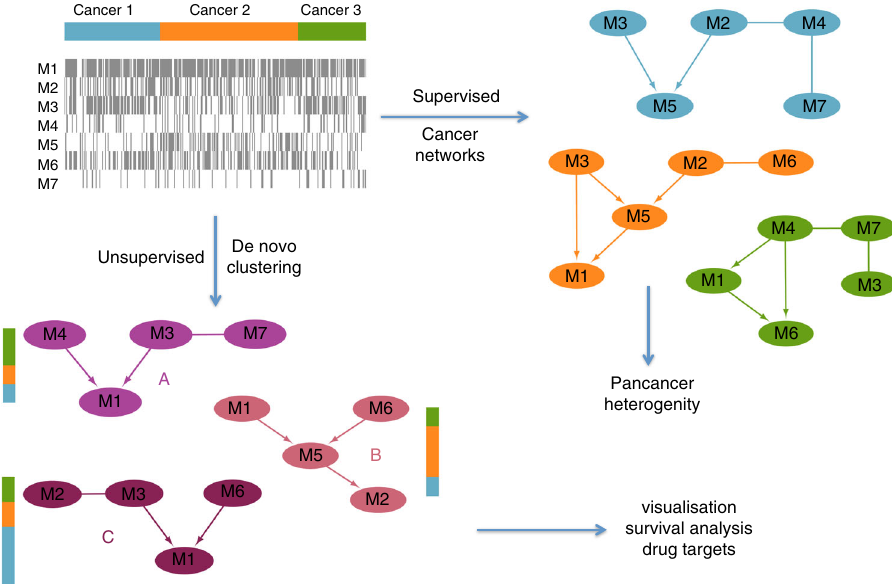
Fig. 1 Overview of the analyses. Starting from the mutation data, we perform two types of analysis. Supervised learning of the Bayesian network structure for each known cancer type, allowing us to uncover mutational interactions and visualise pancancer heterogeneity. Unsupervised clustering of the mutation data into components with common interactions to uncover a novel strati fi cation of the patient